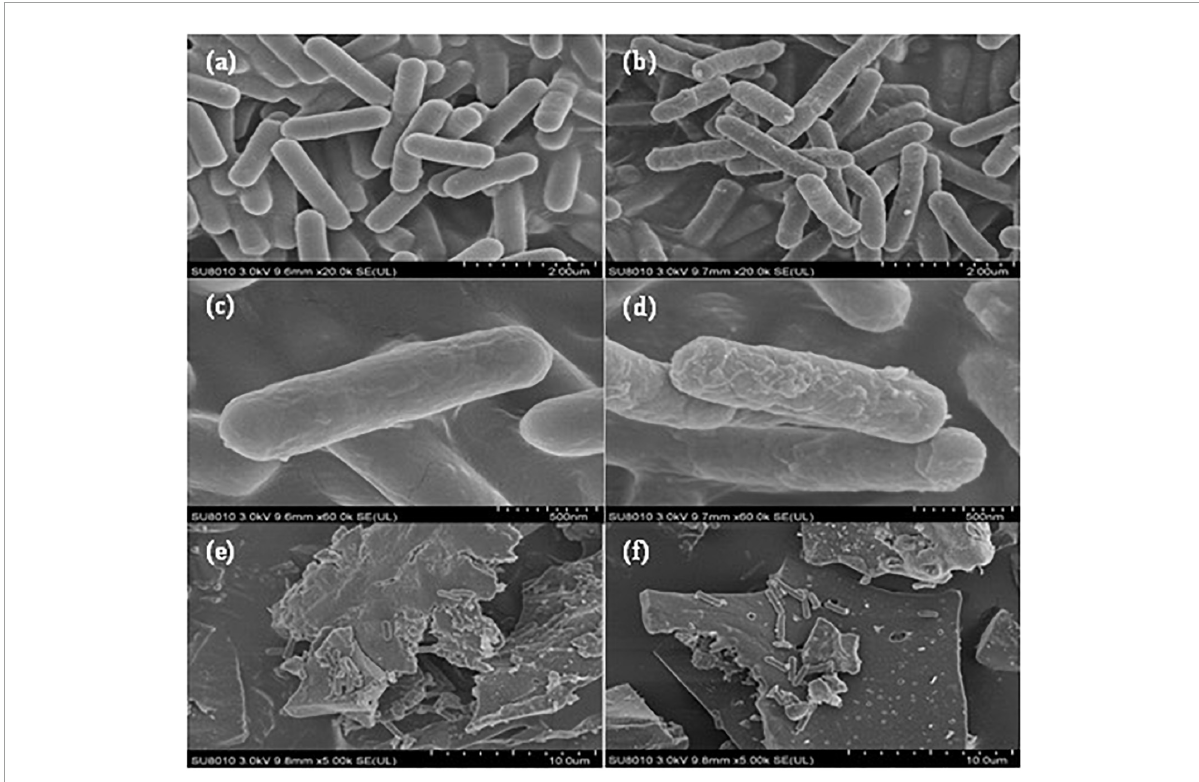
FIGURE1 The bacterial structure of electron microscopy by using Bacillus sp. M6. And amendments (a) M6 strain 2 µ m scale; (b) M6 + rhamnolipid 2 µ m scale; (c) M6 strain 500 nm scale; (d) M6 + rhamnolipid 500 nm scale; (e,f) M6 +